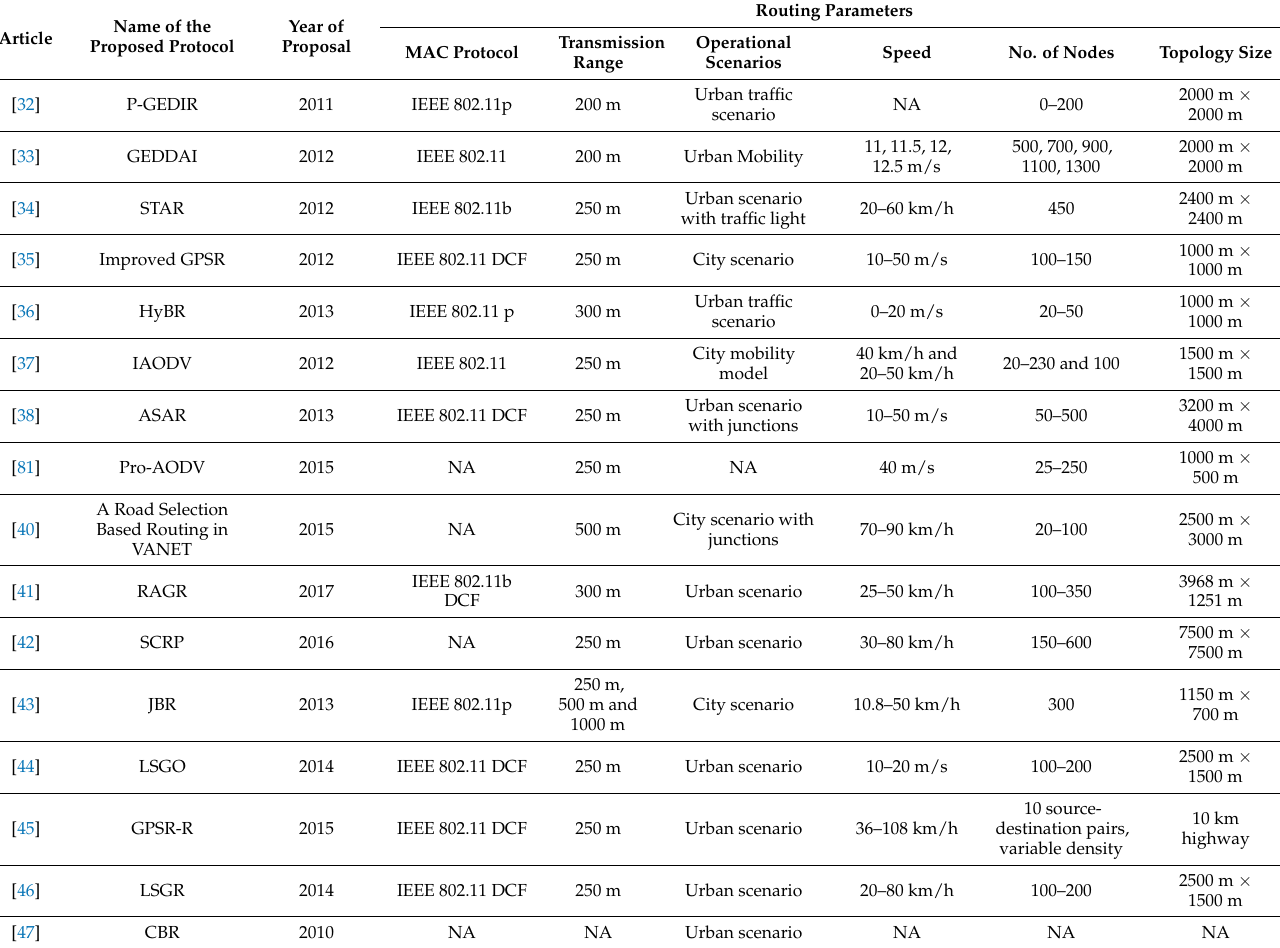
Table 8. Routing parameters of urban scenario with traffic signals/traffic based routing